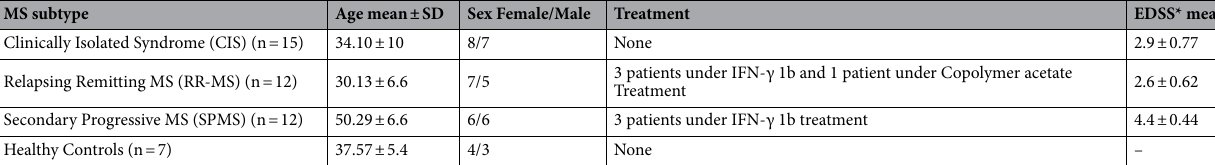
Table 1. Demographic and clinical characteristics of patients with MS. * EDSS expanded disability status